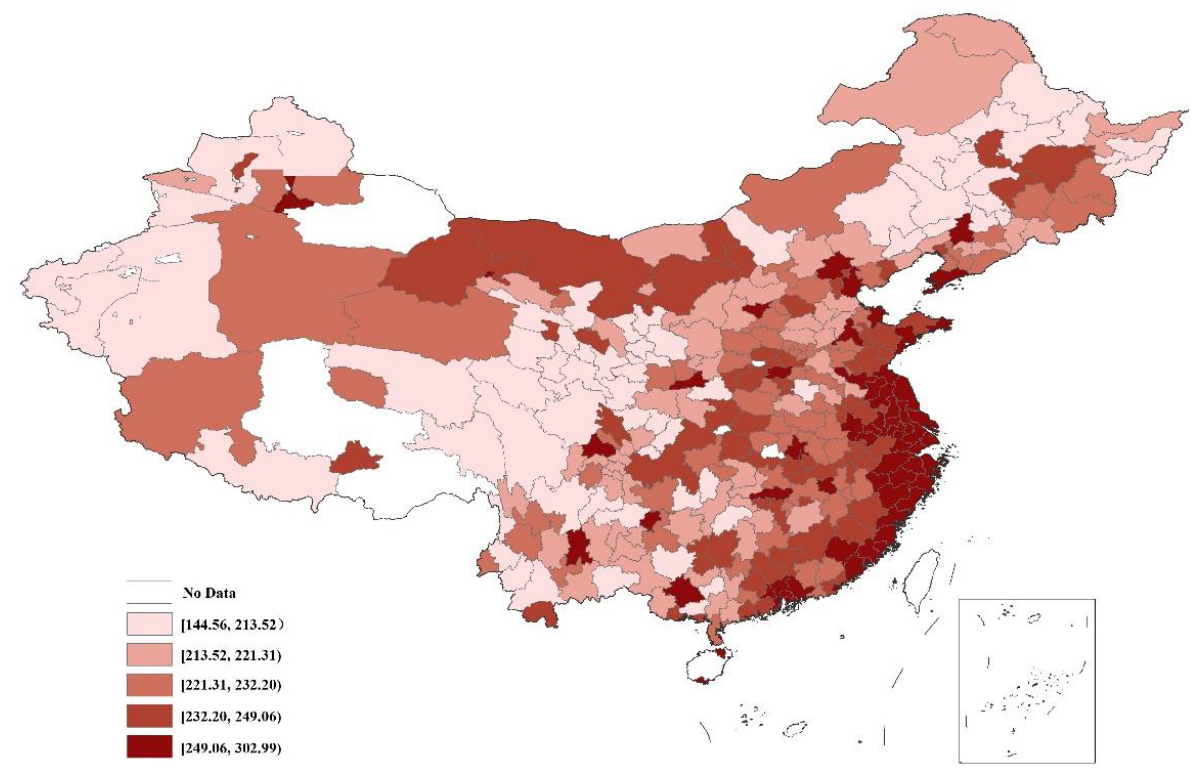
Figure 3. prefecture-level PKU-IFDI and GDP in 2018.